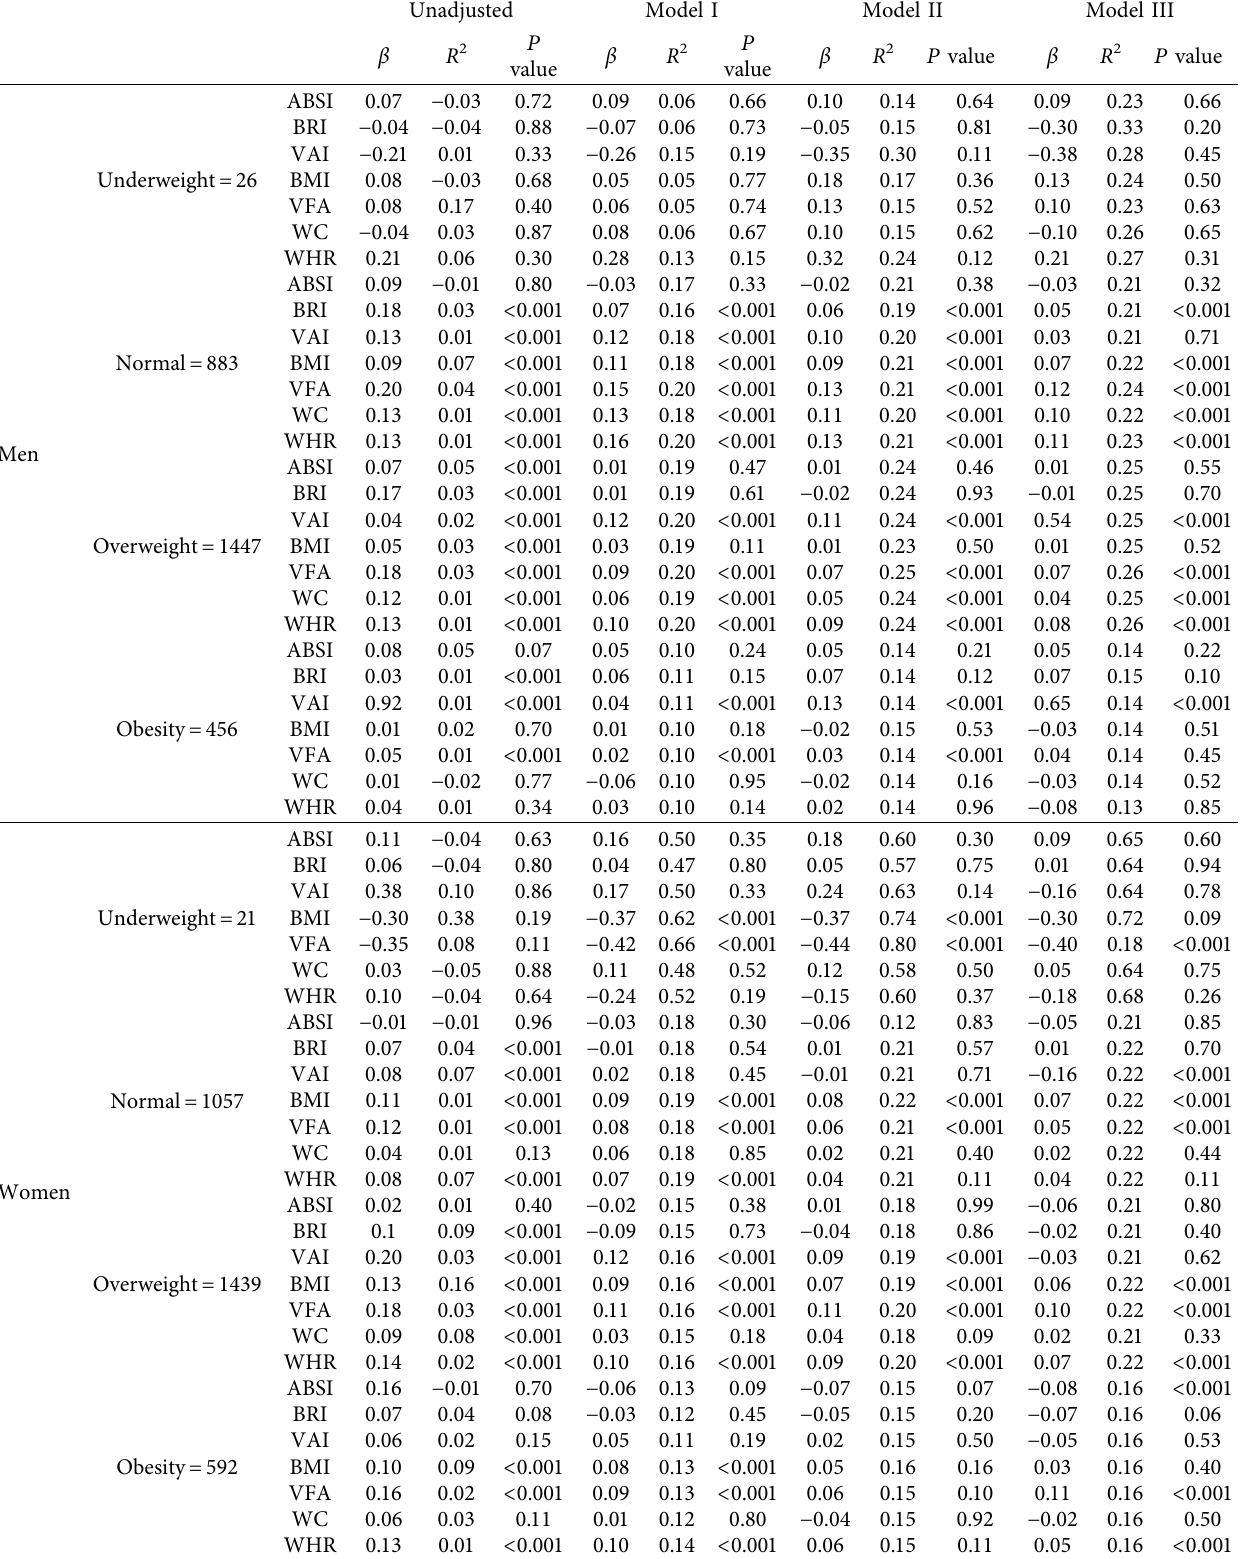
Table 4: Comparison of the association of anthropometric measurements based on obesity status. Unadjusted